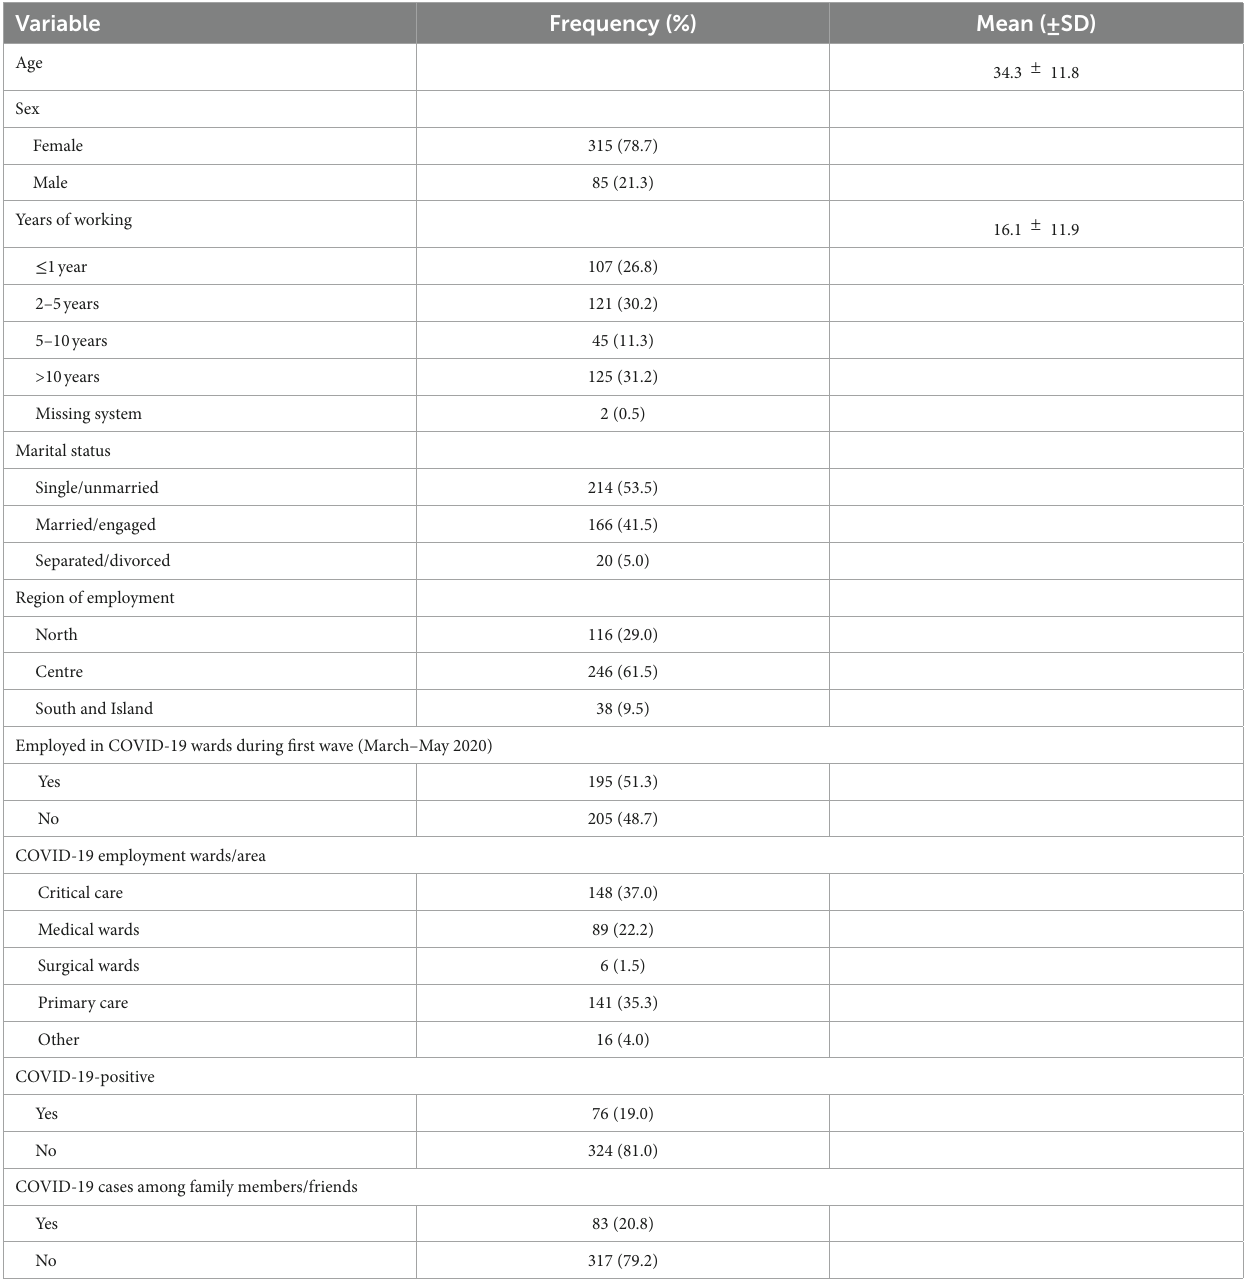
TABLE 2 General characteristics of the survey